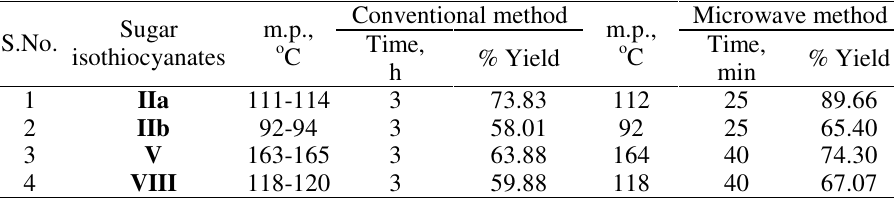
Table 1. Physical data of acetylated sugar isothiocyanates and comparative study of conventional vs . microwave